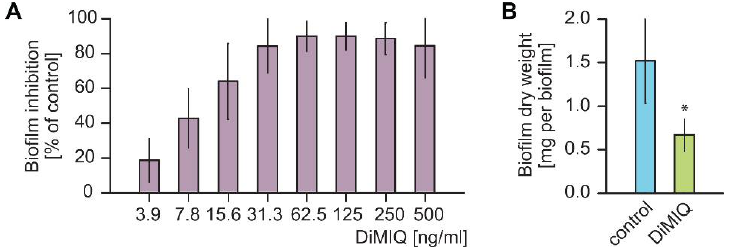
Figure 2. Antibiofilm action of DiMIQ against C. albicans biofilms. ( A ) When used at concentrations greater than 31.3 ng/mL, DiMIQ completely inhibited fungal biofilm formation in vitro. The drug was applied after 6 and 24 h of biofilm growth and its antibiofilm impact was determined using an XTT reduction assay. Data are expressed as percent reduction compared to untreated controls. Mean values shown. ( B ) DiMIQ applied at the ED 50 concentration of 10.8 ng/mL dramatically reduced biofilm dry weight yield. Mean SD values shown. * p < 0.01.